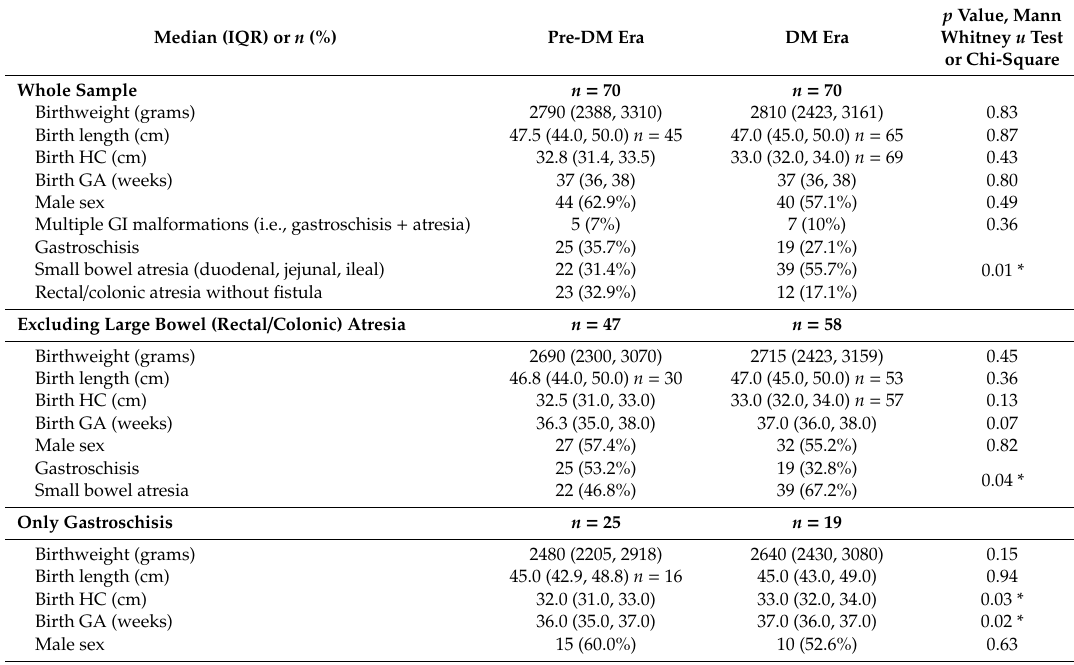
Table 1. Characteristics of the